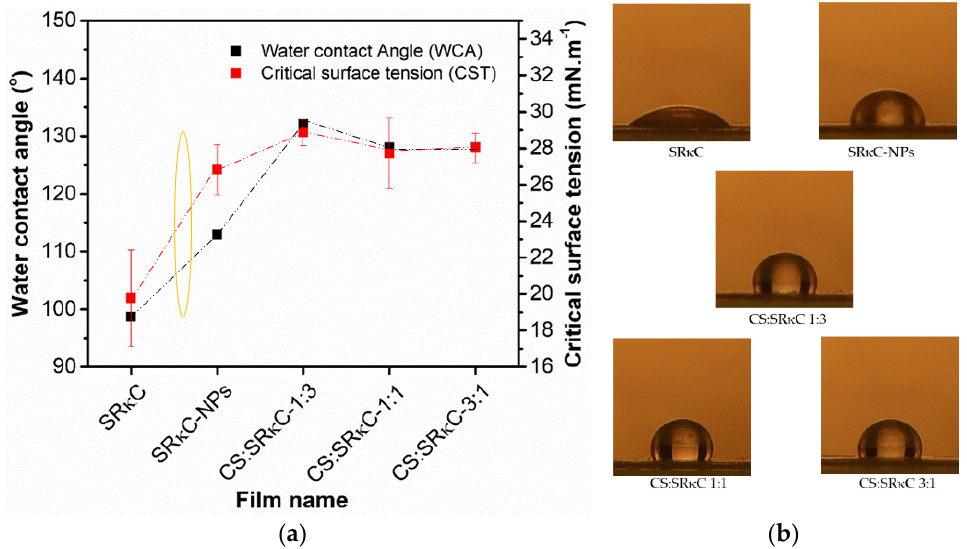
Figure 6. ( a ) Water contact angle and critical surface tension of bionanocomposite films; ( b ) images of water droplets on the surface of bionanocomposite